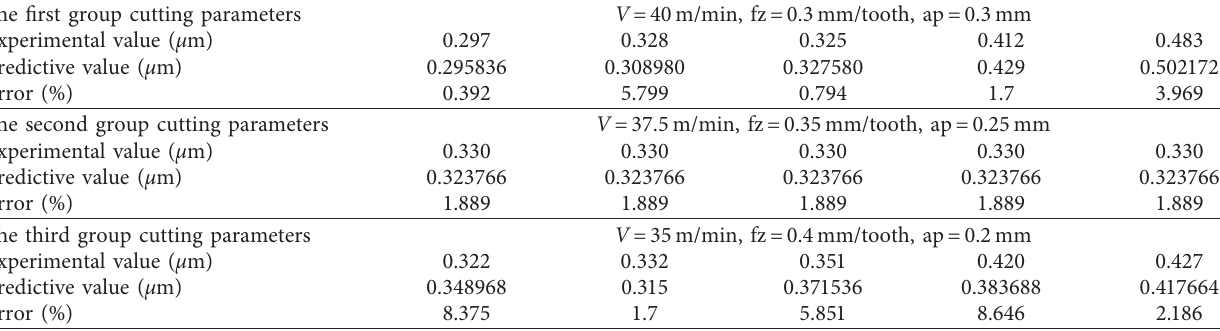
Table 5: Comparison for the experimental and predictive surface roughness for each set of the cutting parameters. The first group cutting parameters